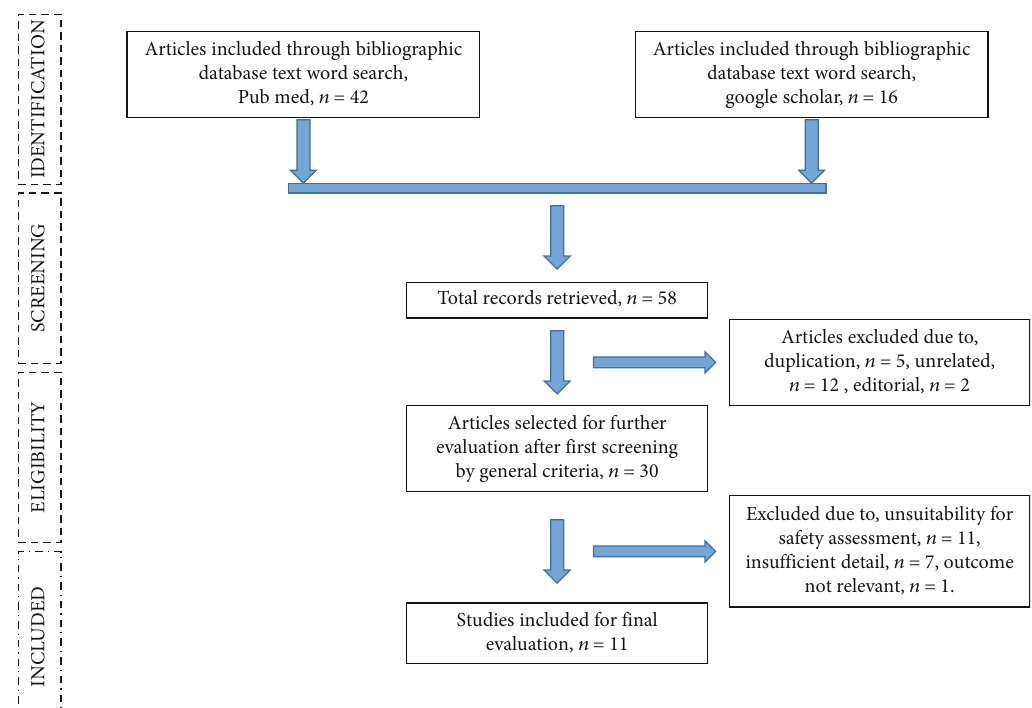
Figure 1: Article selection